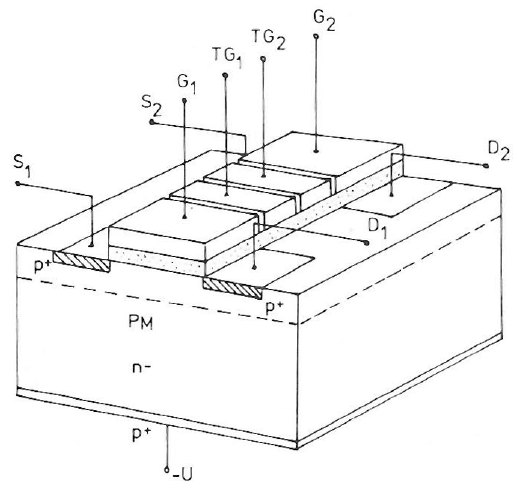
Figure 2. Ping-pong arrangement of DEPFETs in the original publication.